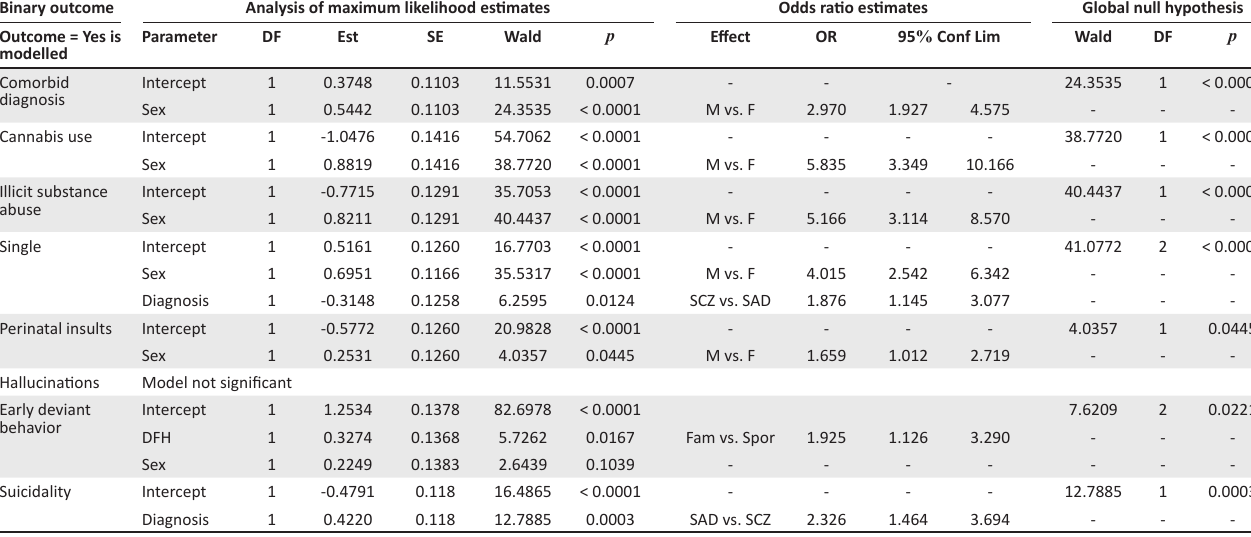
TABLE 1-A1: Logit models where predictors entered are differential family history, sex, diagnosis (schizophrenia or schizoaffective disorder). Binary outcome Analysis of maximum likelihood estimates